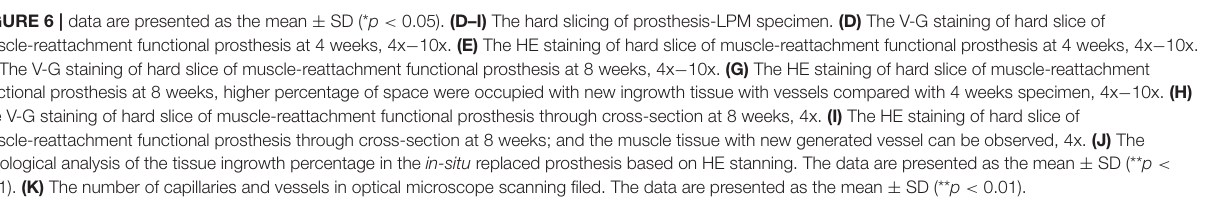
FIGURE 6 | data are presented as the mean ± SD (* p < 0.05). (D–I) The hard slicing of prosthesis-LPM specimen. (D) The V-G staining of hard slice of muscle-reattachment functional prosthesis at 4 weeks, 4x − 10x. (E) The HE staining of hard slice of muscle-reattachment functional prosthesis at 4 weeks, 4x − 10x. (F) The V-G staining of hard slice of muscle-reattachment functional prosthesis at 8 weeks, 4x − 10x. (G) The HE staining of hard slice of muscle-reattachment functional prosthesis at 8 weeks, higher percentage of space were occupied with new ingrowth tissue with vessels compared with 4 weeks specimen, 4x − 10x. (H) The V-G staining of hard slice of muscle-reattachment functional prosthesis through cross-section at 8 weeks, 4x. (I) The HE staining of hard slice of muscle-reattachment functional prosthesis through cross-section at 8 weeks; and the muscle tissue with new generated vessel can be observed, 4x. (J)